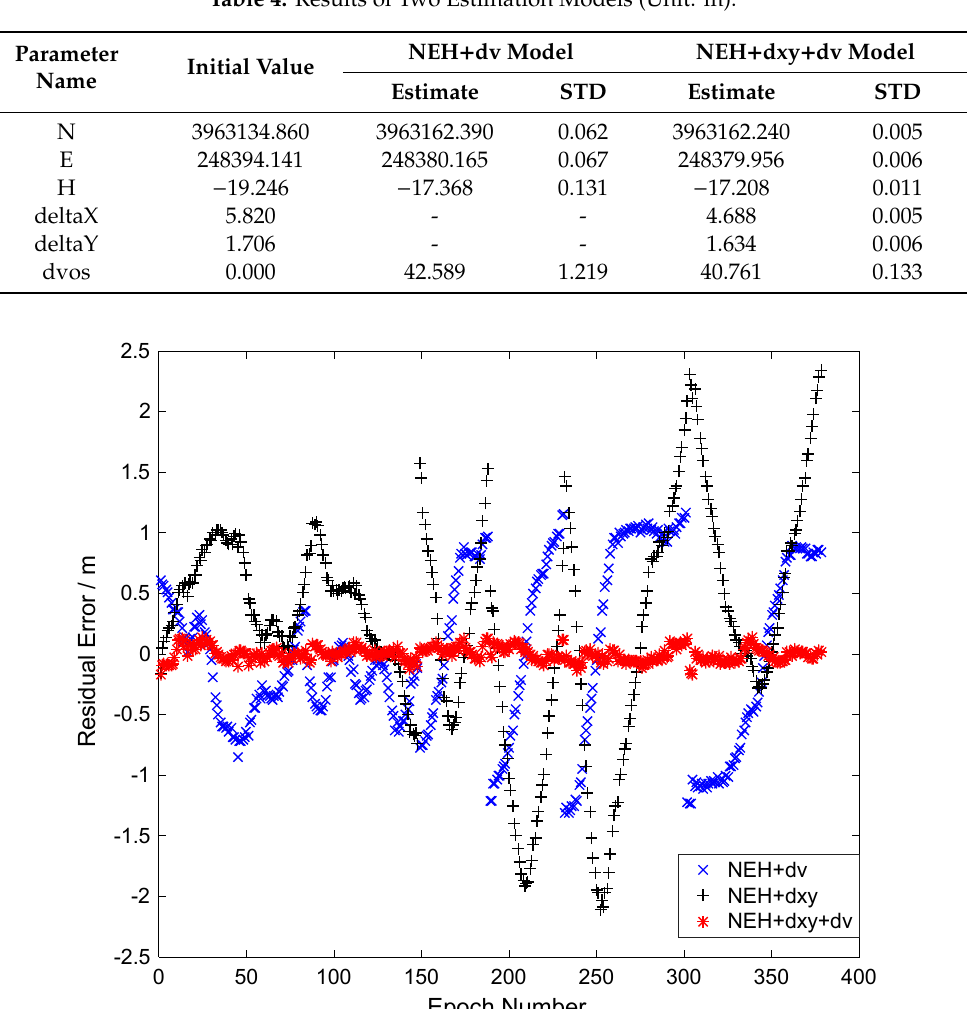
Figure 6. Time series of residual errors for the three models.